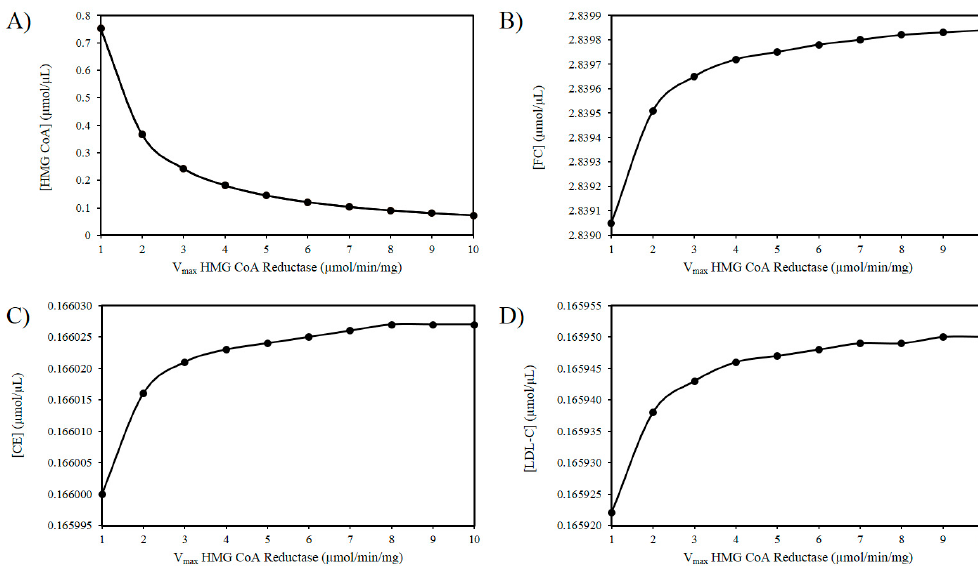
Figure 2. Effect of HMG-CoA reductase (HMGCR) modulation on ( A ) HMG-CoA, ( B ) FC, ( C ) LDL-C, and ( D ) CE.